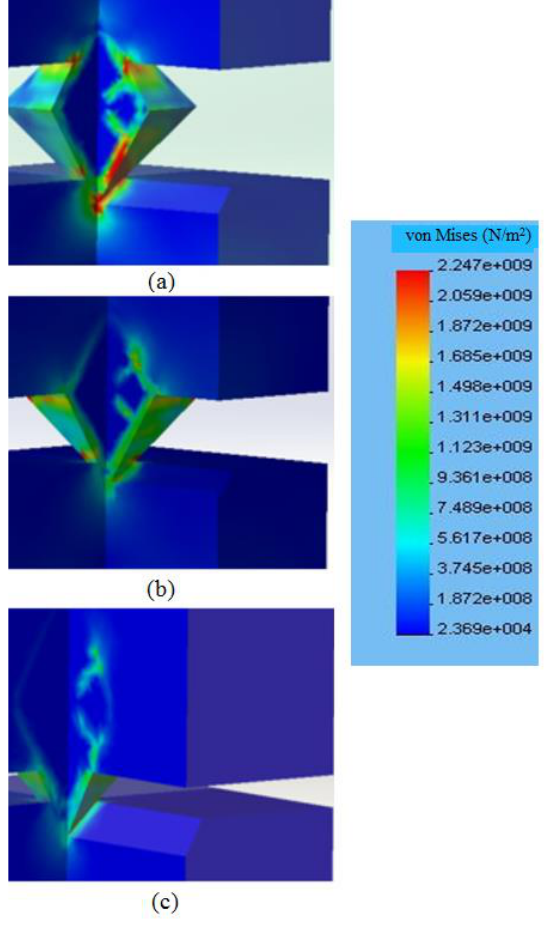
Figure 4. Visualization of stress fields in “SHM–grain–bond” system in accordance with embedment of grain in bond ( h emb ) upon contact with the top: ( a ) h emb = 20%, ( b ) h emb = 50%, and ( c ) h emb = 65%.